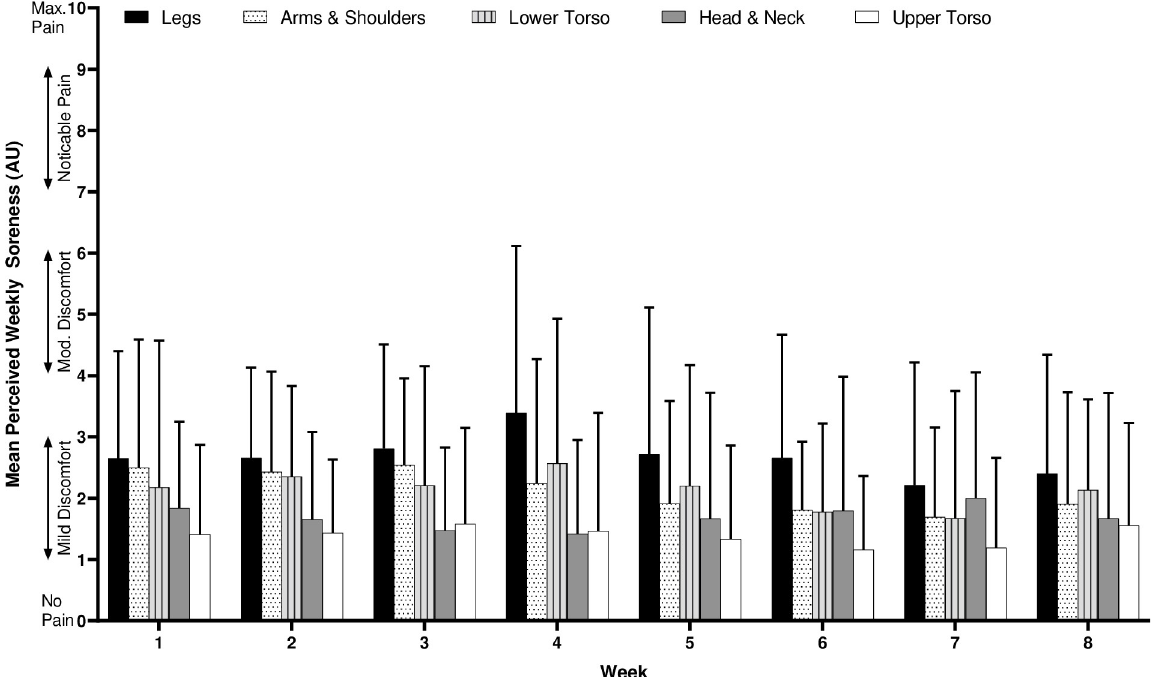
Fig 2. Between and within week comparisons of perceived body region soreness (AU). See accompanying text for statistical comparisons between regions. Error bars = SD.